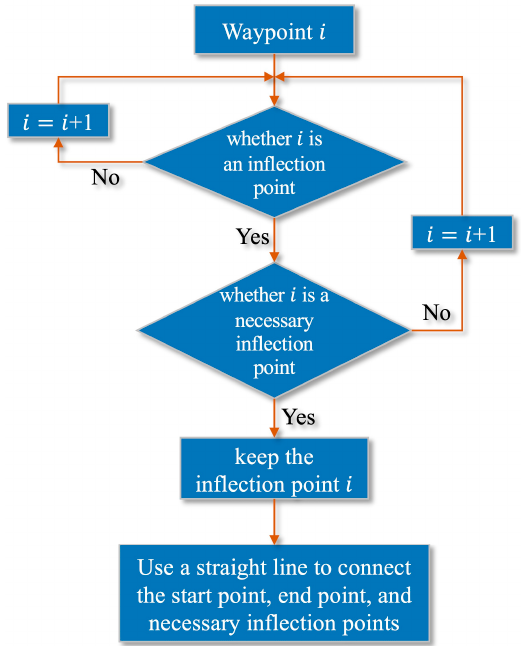
Figure 5. Inflection point optimization algorithm flow chart.